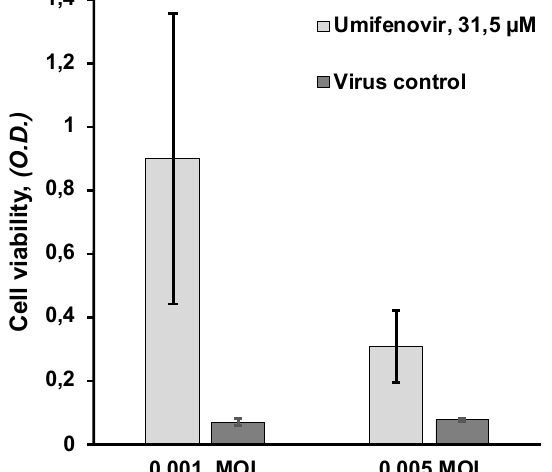
Figure 4. Antiviral activity of umifenovir against SARS-CoV-2 virus. Umifenovir (UMF) and hydroxychloroquine (HCQ) were added to Vero ССL81 cells at various concentrations. The cellular cytotoxicity test of Vero ССL81 cells was i n- cluded in the experiment, and the resulting curves are shown (UMF, HCQ). After 2 h of incubation, virus at dose of 0.001 ( A ) and 0.005 MOI ( B ) was added to wells, except ‘cell control’ wells, and cells were incubated at 37 °C in a hu midified 5% CO 2 atmosphere for 5 days. The CPE and rate of cell viability was measured using MTT assay. ( A ) Percent inhibition of SARS-CoV-2 (strain Dubrovka) by umifenovir (UMF+V) and hydroxychloroquine (HCQ+V) at MOI 0.001 and cyto- toxicity (UMF, HCQ). ( B ) Percent inhibition of SARS-CoV-2 (strain Dubrovka) by umifenovir (UMF+V) and hy- droxychloroquine (HCQ+V) at MOI 0,005) and cytotoxicity (UMF,HCQ). ( C ) The EC50 values are represented as mean ± SD; the three-parameter log-logistic (LL.3) function was used.